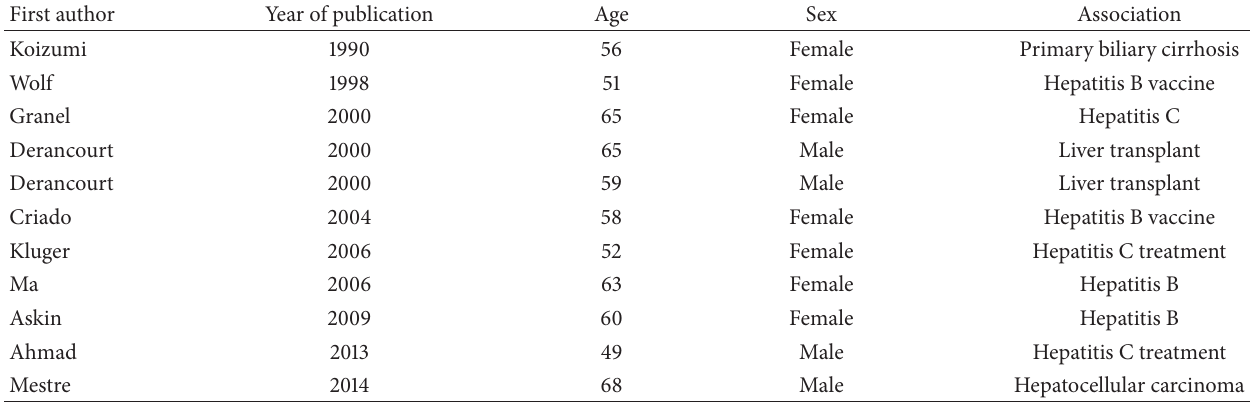
Table 1: Summary of the reported association between liver disease and granuloma